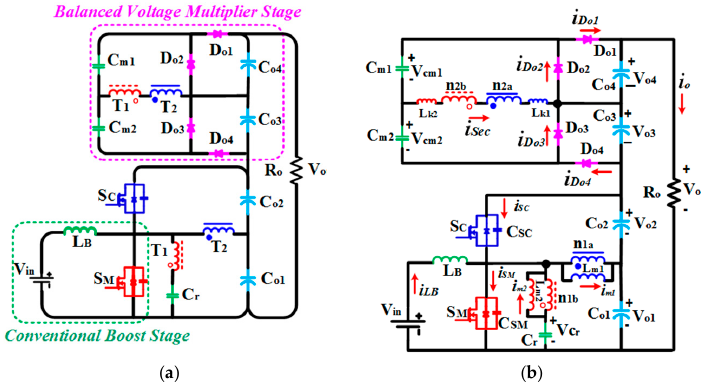
Figure 2. The schematic of the proposed converter: ( a ) proposed converter; and ( b ) the equivalent circuit.